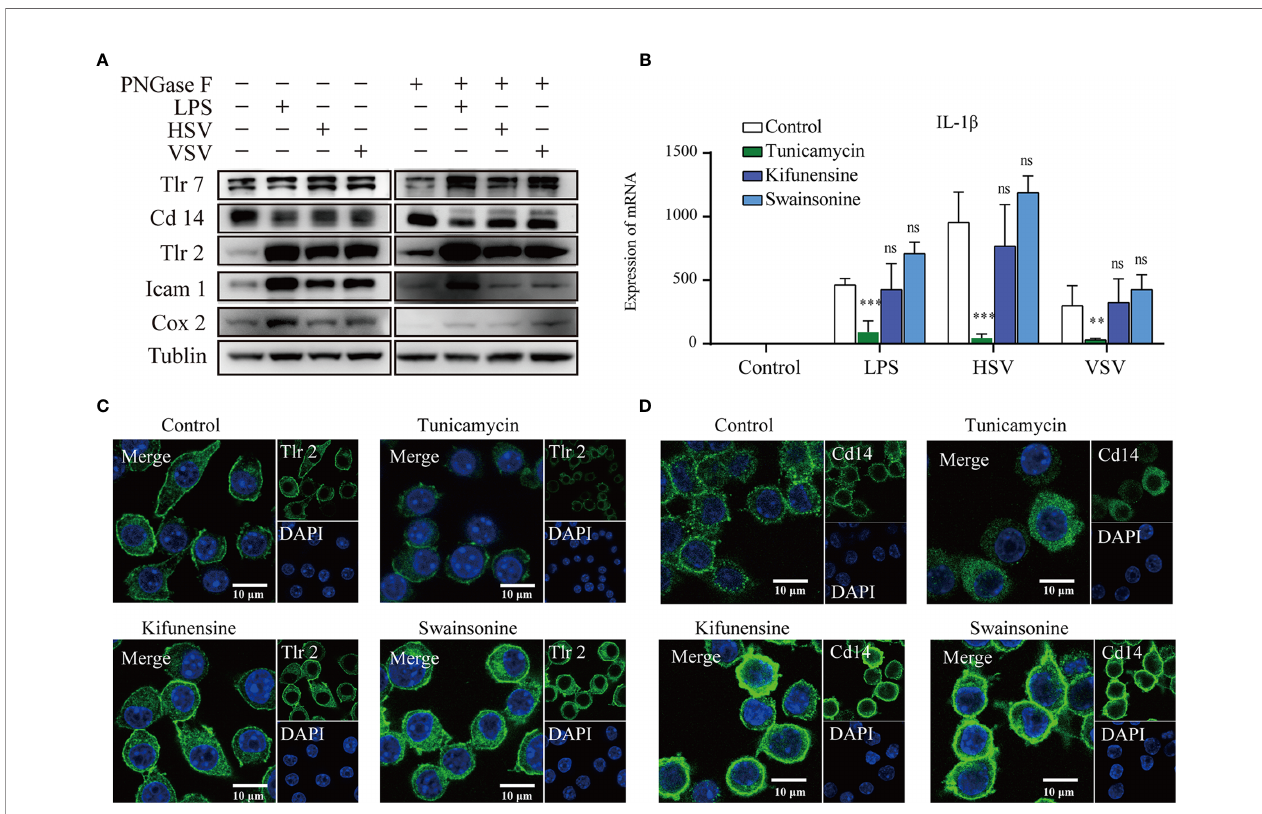
FIGURE 5 | Glycosylation inhibitors altered the membrane location. Western blots of Tlr7, Cd14, Tlr2, Icam1, Cox2, and tubulin with or without PNGase F treatment (A) . The mRNA expression of IL-1 b (B) in RAW264.7 cells under different stimulations after treatment with different glycosylation inhibitors (ns, no signi fi cant vs the control group, **p value < 0.01, ***p value < 0.001). Confocal images of Tlr2 (C) and Cd14 (D) after treatment with different glycosylation inhibitors. Scale bar